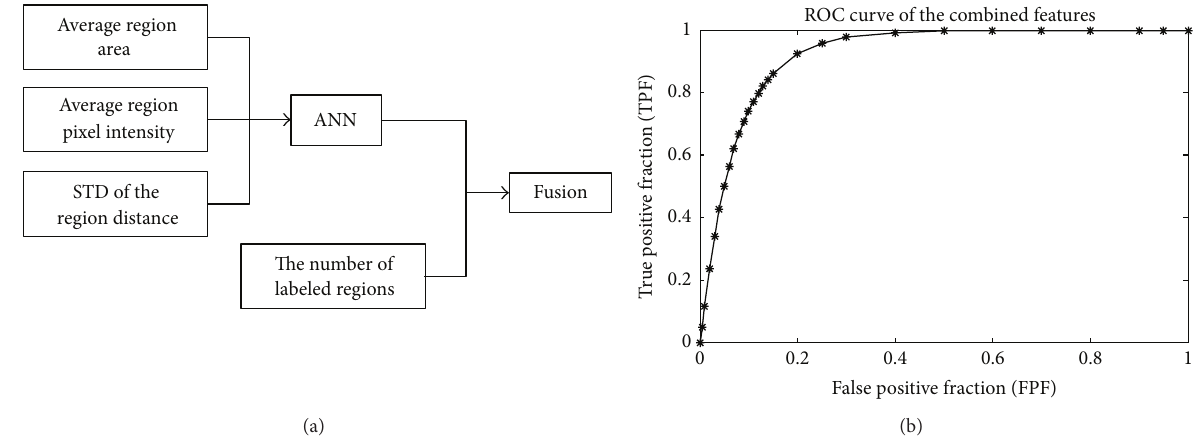
Figure 5: (a) The architecture of the classifier for the four selected features selected in the off-line CAD scheme. (b) The estimated ROC curve of the classifier. The AUC of the ROC curve is 0.9244 ± 0.026